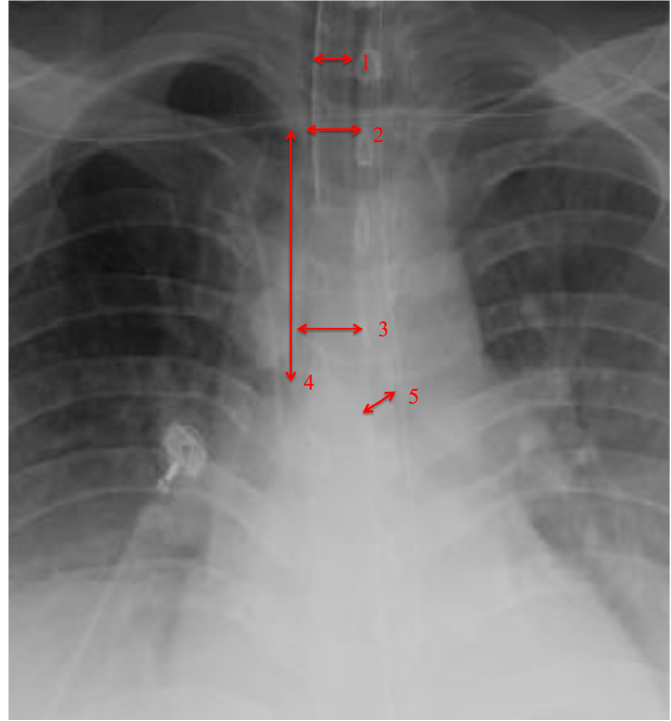
Figure 2. Measurement of trachea anatomy. 1 = endotracheal tube measurement for scale, 2 = trachea diameter at 1st rib, 3 = trachea diameter at carina, 4 = trachea length 1st rib to carina, 5 = left main bronchus diameter.